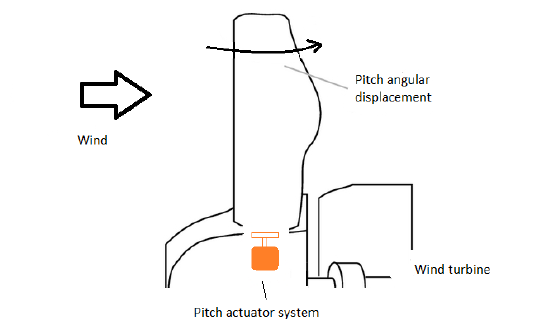
Figure 1. A schematic representation of the pitch actuator location in a